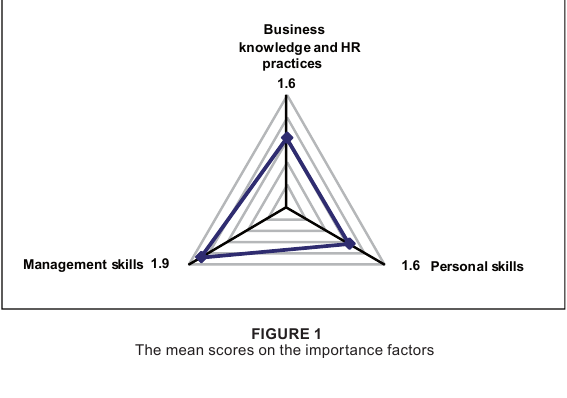
FiguRE 1 The mean scores on the importance factors